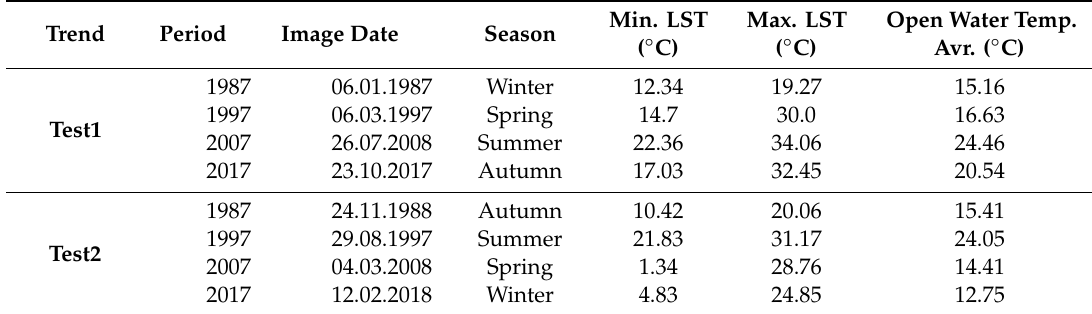
Table 3. Images inventory of the two datasets for LSTn seasonal-independent test.